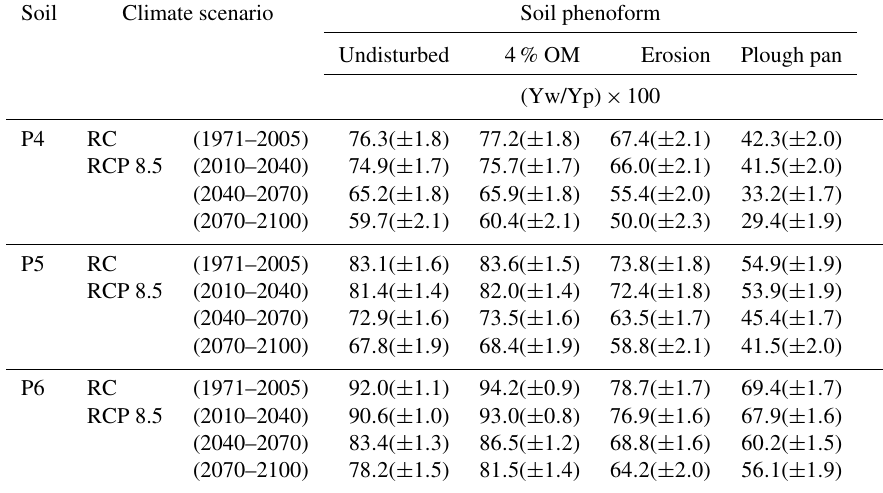
Table 3. SQr index ((Yw/Yp) × 100) for the three selected soils and the four climate periods. Yp is assumed to be 18tonsha − 1 .